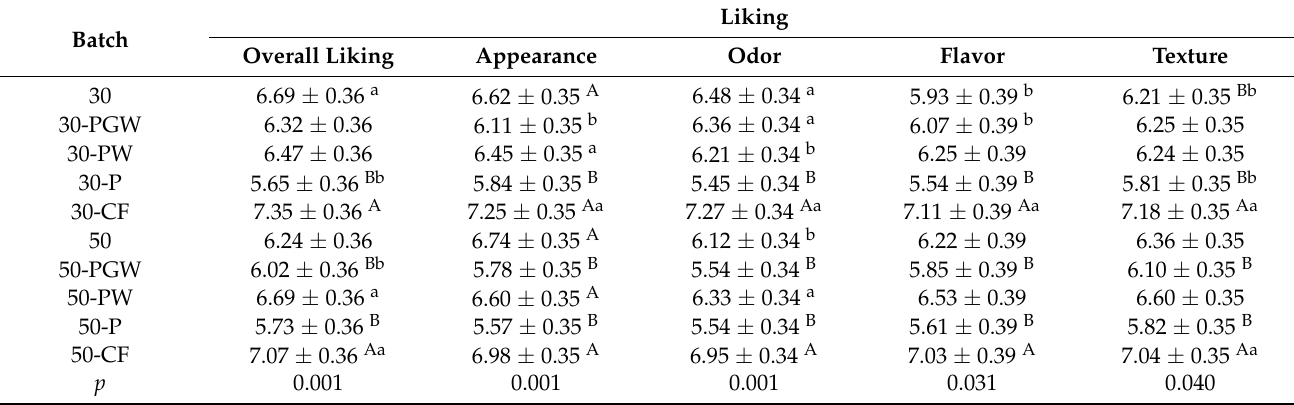
Table 5. Hedonic test of Cacciatore salami: effect of products (mean ± SE) (1) .